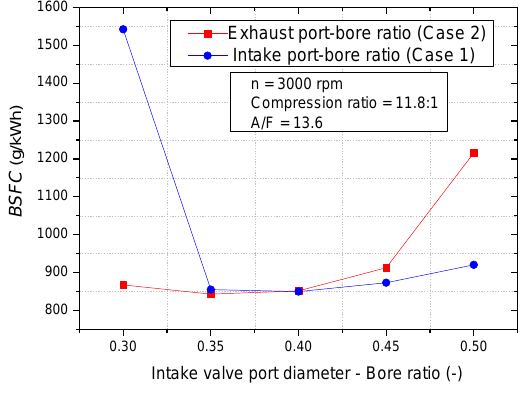
Figure 18. BSFC versus VPD / B.